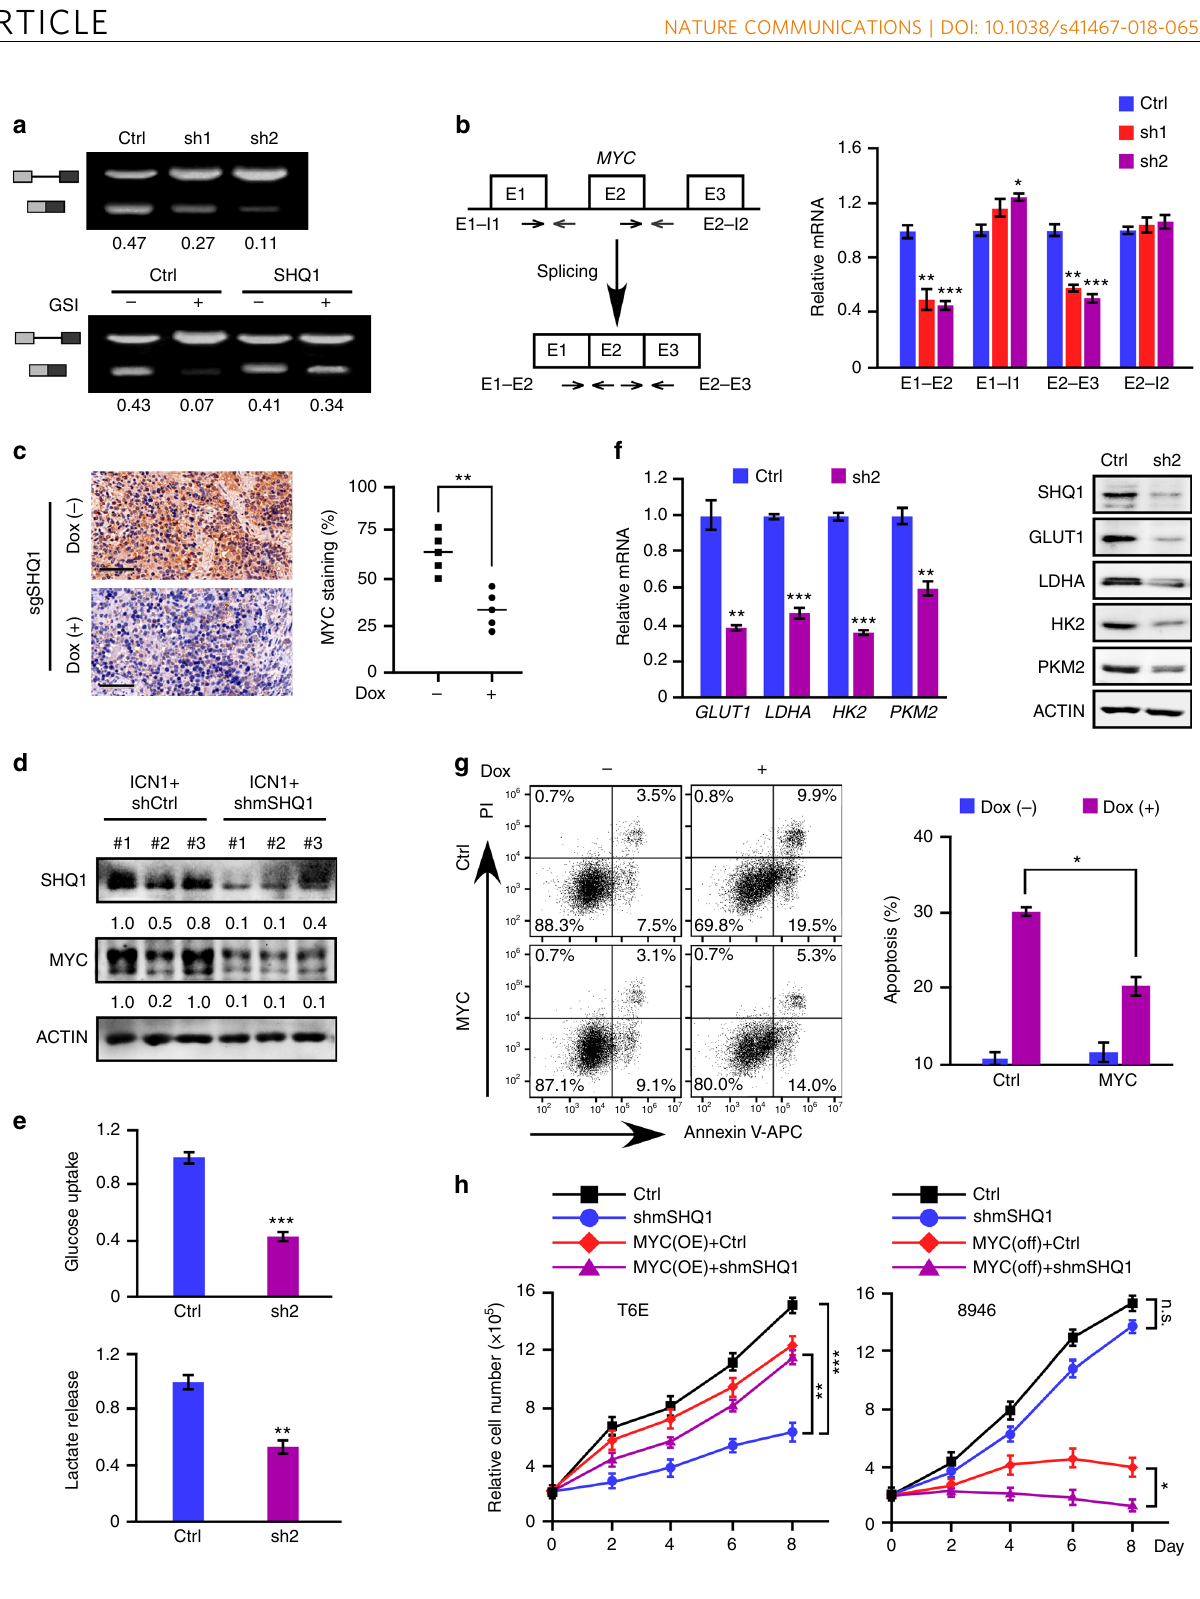
MYC in cell viability, we overexpressed MYC in JURKAT cells, in which doxycycline treatment induced SHQ1 knockout (Supple- mentary Fig. 6). MYC -overexpressed cells signi fi cantly